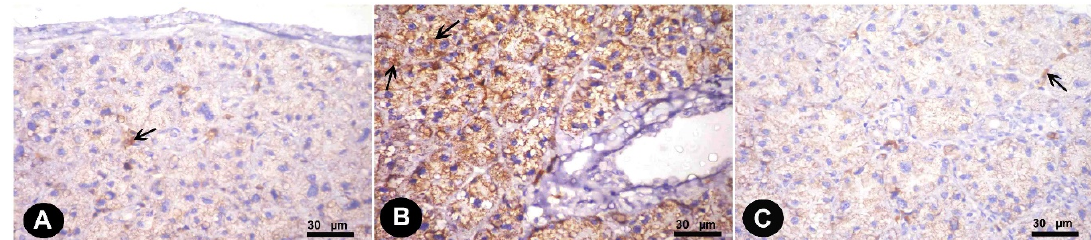
Figure 2. Immunohistochemically stained sections in the parotid of albino rats of different groups. Cytoplasmic immune reaction for 4-hydroxynonenal (4-HNE) ( A ) Control group (weak positive reaction “arrow”) ( B ) Alternariol group (stronger positive reaction “arrow”) ( C ) AOH + gallic treated group (moderate reaction “arrow”).